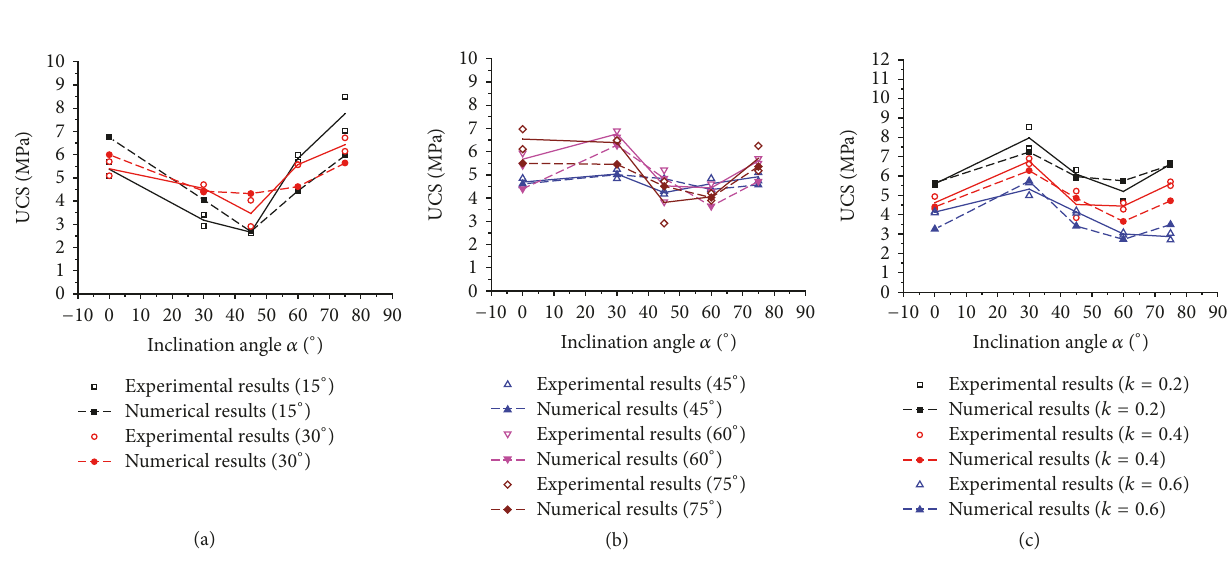
Figure 7: UCS of specimens from laboratory and numerical